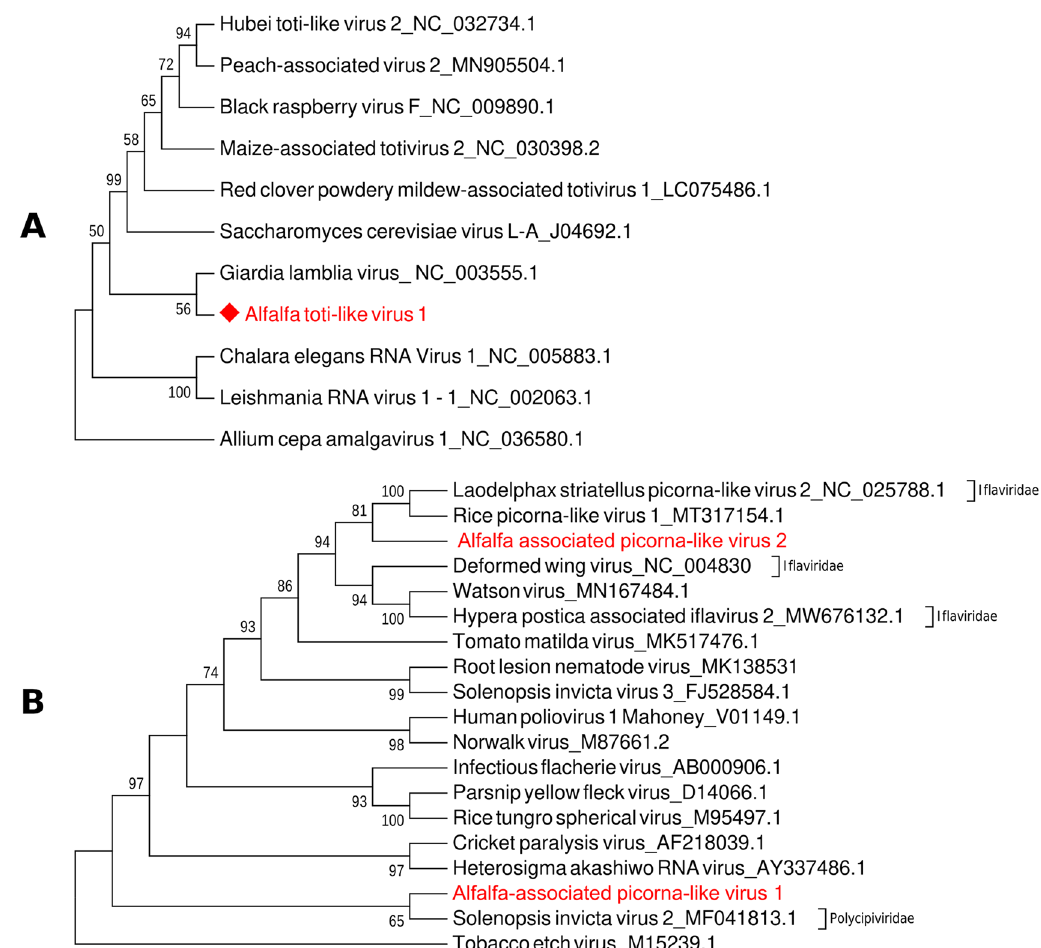
Figure 5. Phylogenetic analysis of the newly identified toti-like and picorna-like viruses found in alfalfa samples collected from production fields in the U.S. Pacific Northwest in 2019/2020. ( A ) The phylogenetic tree was deduced from the ClustalW alignment of the proposed alfalfa toti-like virus with the complete nucleotide sequences of the representative species and unclassified members of the family Totiviridae . Allium cepa amalgavirus 1_(NC_036580.1) was used as an outgroup. ( B ) The phylogenetic tree was deduced from the ClustalW alignment of the proposed alfalfa-associated picorna-like viruses AAPLV1 and AAPLV-2 with